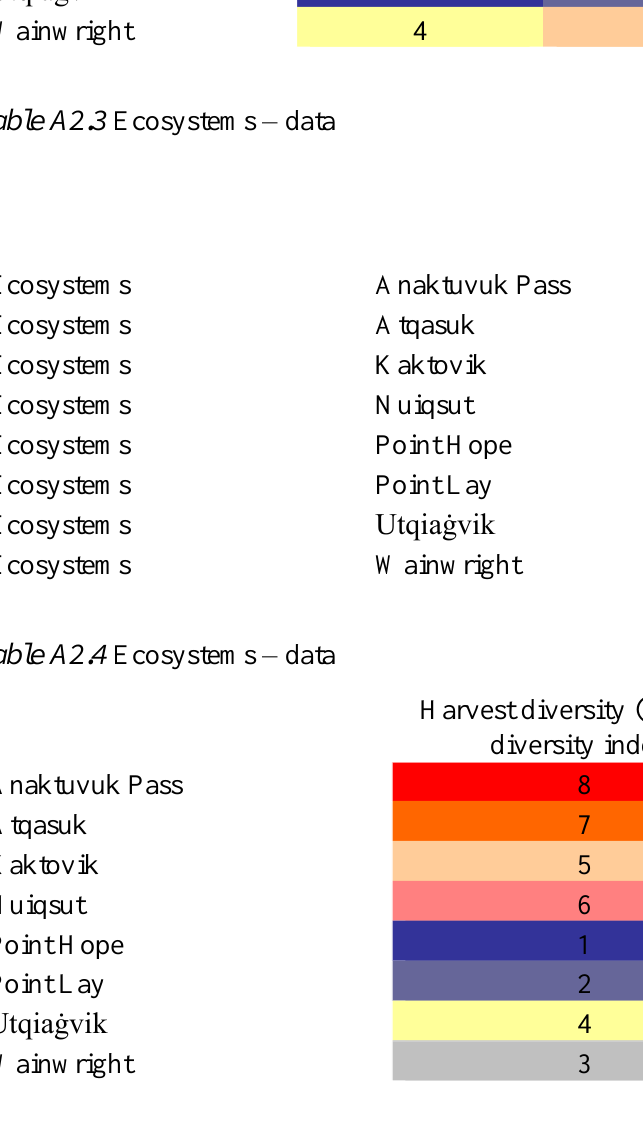
Table A2.3 Ecosystems – data